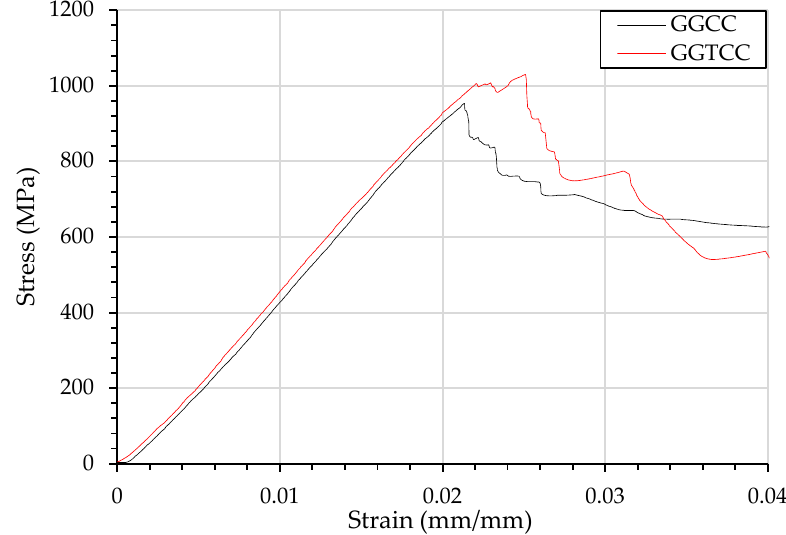
Figure 13. Flexural testing using three-point bending of composites beams and resulting stress strain curve of GGCC and GGTCC.